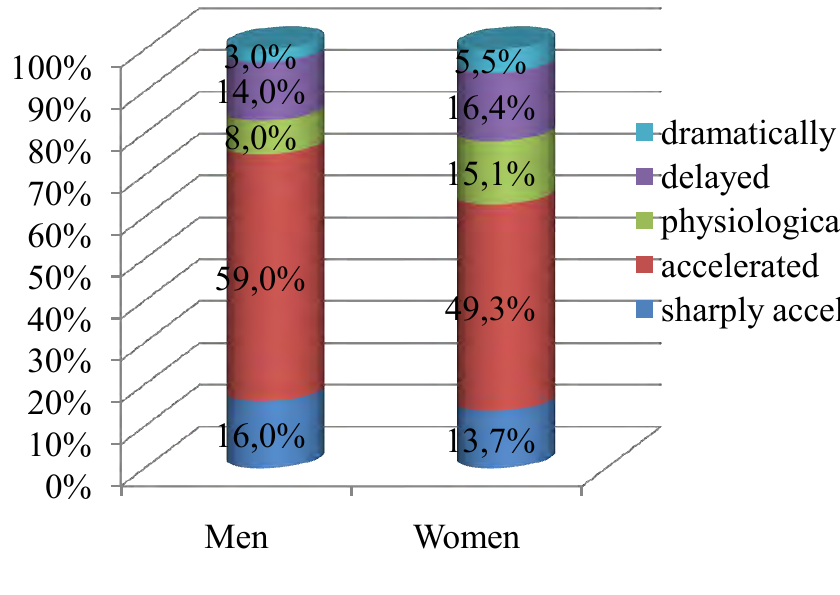
Fig.1. Temp of ageing of 50-60 years old men and women